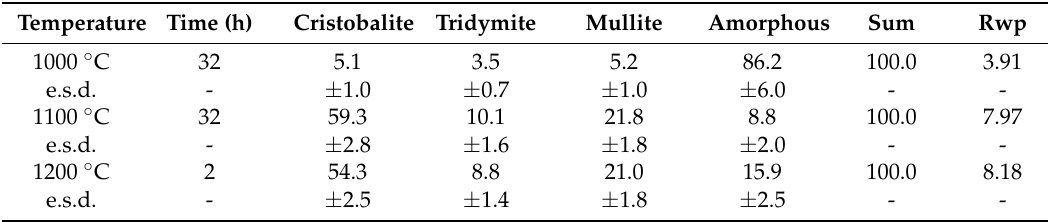
Table 3. Mineralogical compositions of ES-NH heated at the temperatures and for the time indicated (values in wt %).